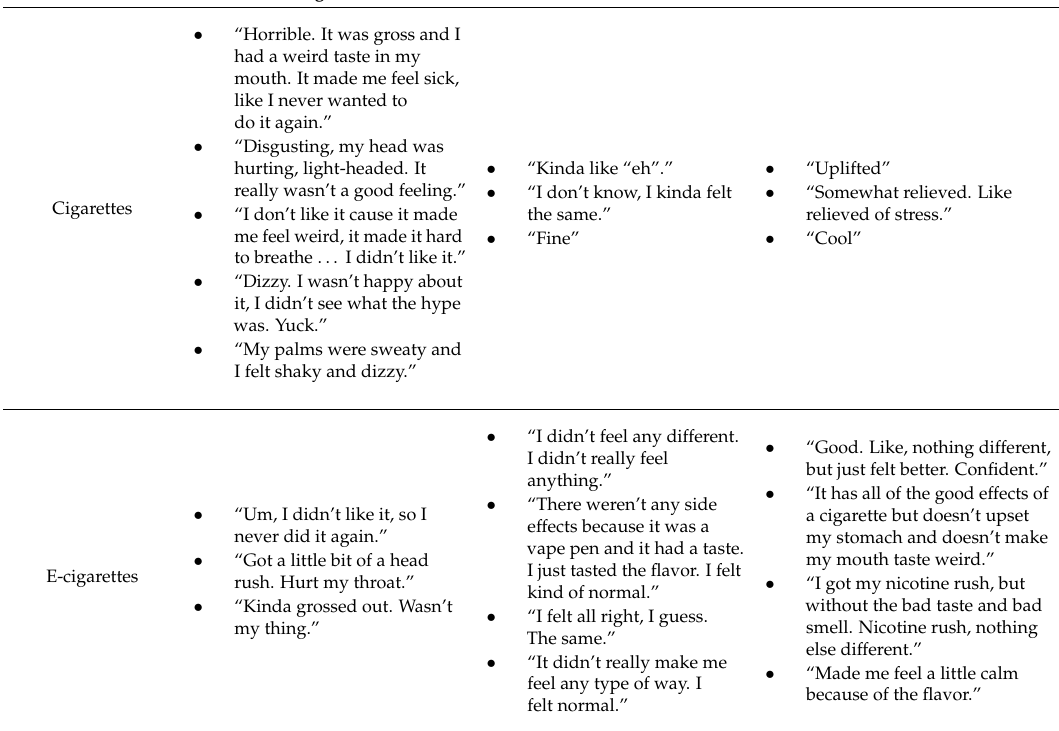
Table 3. Example open-ended responses about first experiences with cigarettes and e-cigarettes. Tobacco